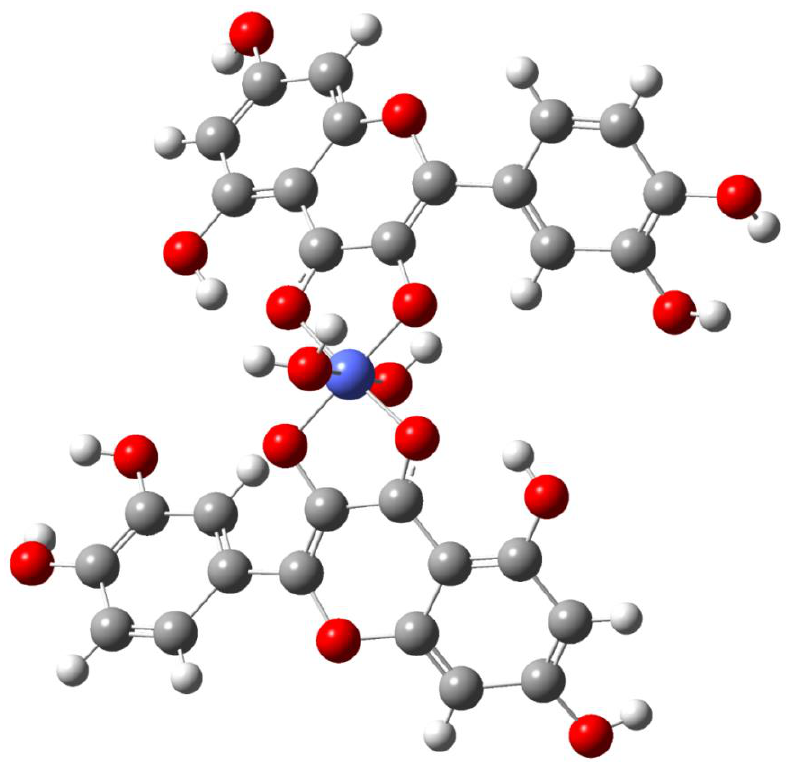
Figure 5. Proposed structure of dehydrated cobalt complex with quercetin.